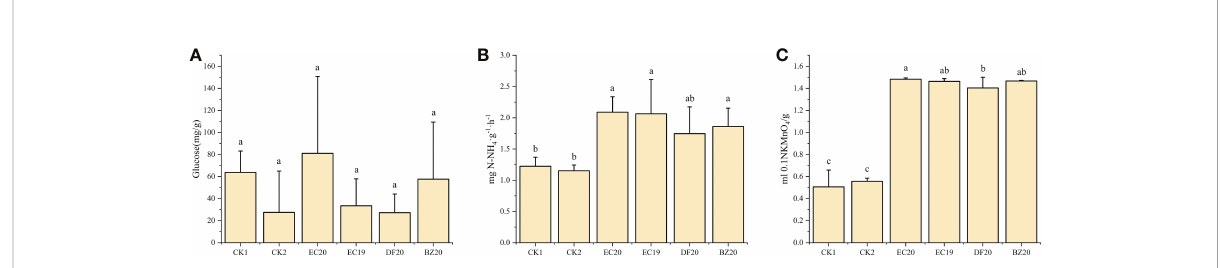
FIGURE 6 Effect of bio-fertilizer on soil enzyme activity: (A) soil transforming enzymes; (B) urease; (C) peroxidase. Data represent the mean ± SD of at least three independent experiments, and different lowercase letters indicate that differences between different treatment groups reached signi fi cance at the P<0.05 level.